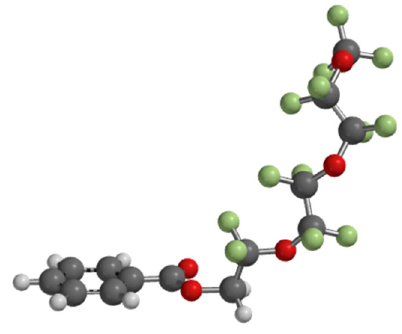
Figure 7. A low energy conformation of a benzoic acid ester of the PF-PEG tail of W789 .